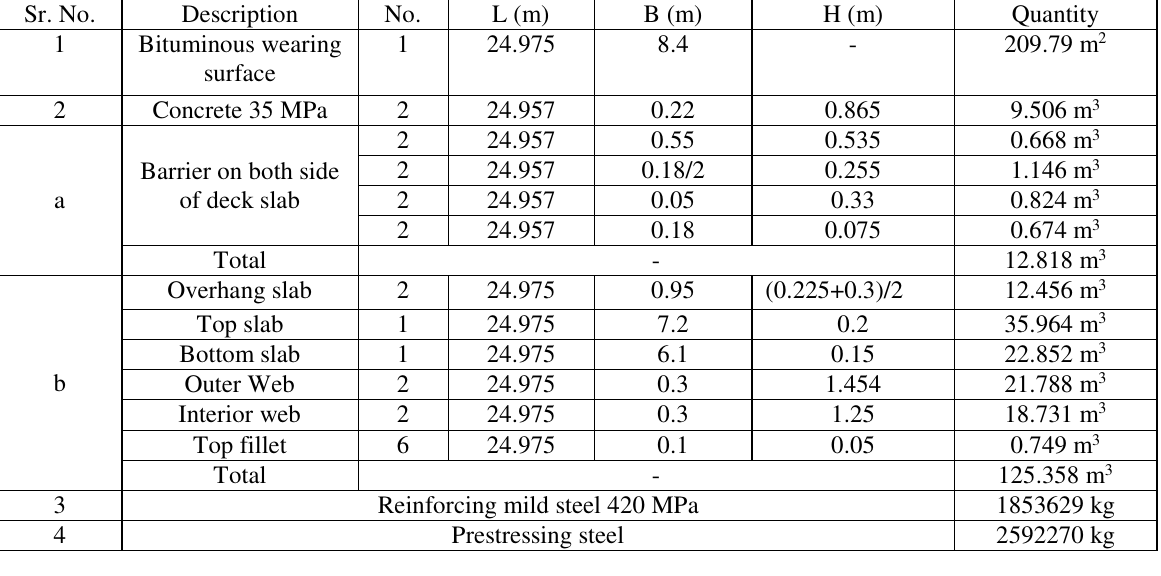
TABLE 8. COMPARISON OF MATERIALS FOR BOX AND T BEAM GIRDER BRIDGE Description